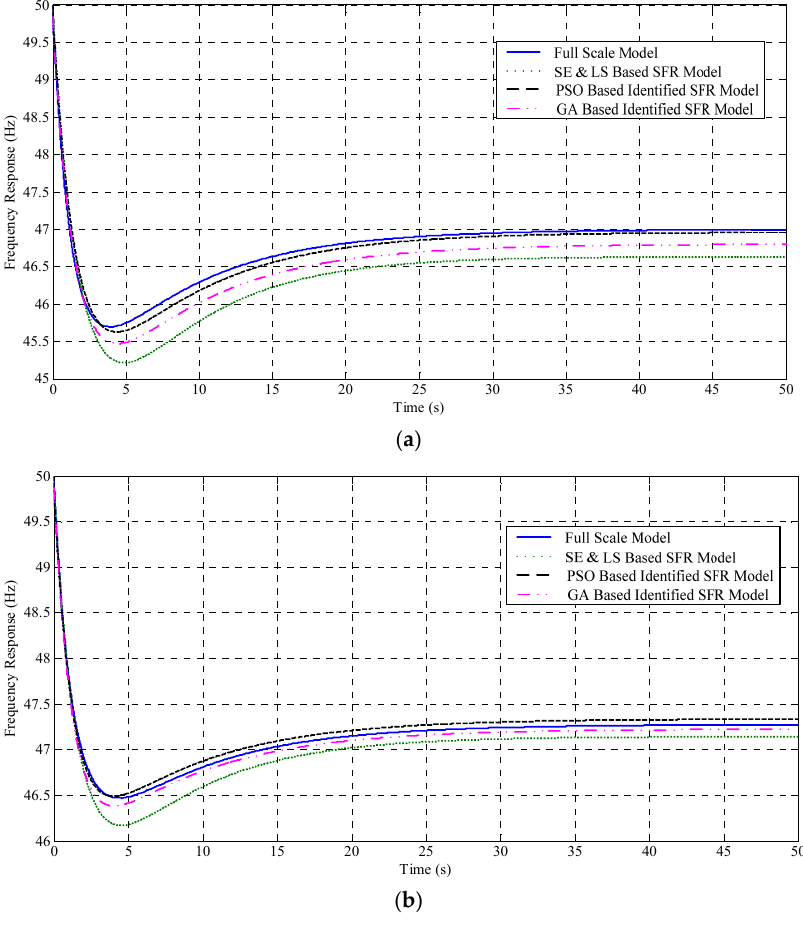
Figure 11. Comparison between the full scale model and simplified SFR model response: ( a ) Peak demand; ( b ) Valley demand.